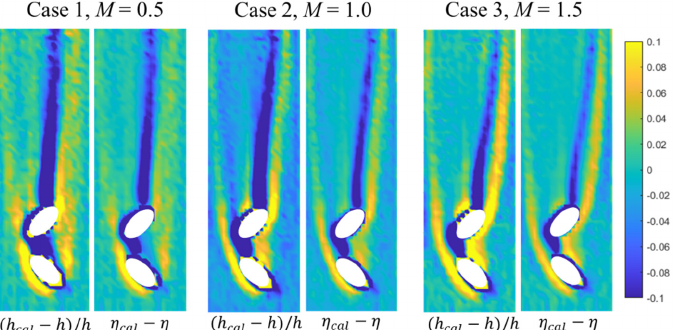
Figure 6. Errors of calculated heat transfer coefficient and film cooling effectiveness at different M .